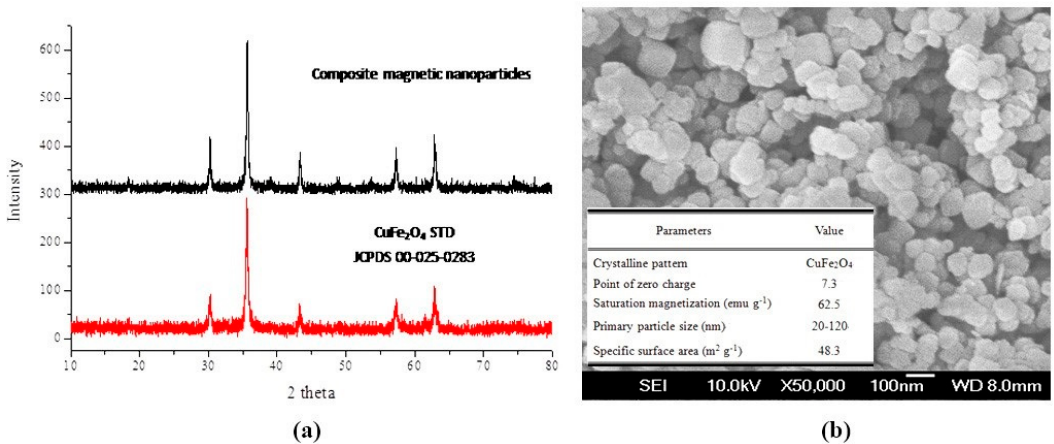
Figure 1. ( a ) XRD spectra; and ( b ) SEM image of the composite magnetic nanoparticles.